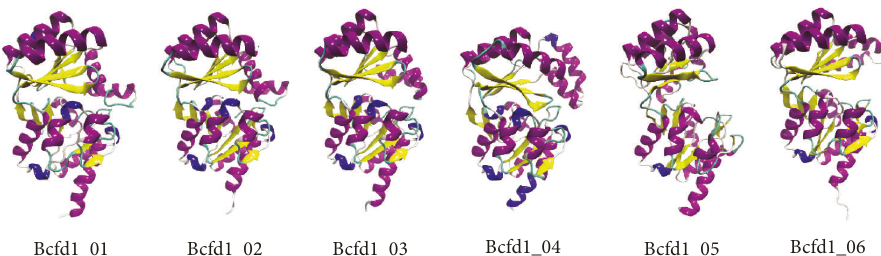
Figure 1: Predicted tertiary structure models of Bcfd1. Bcfd1_01, Bcfd1_02, Bcfd1_03, Bcfd1_04, Bcfd1_05, and Bcfd1_06 were obtained using I-Tasser, Robetta, TrRosetta, Robetta ab initio, C-Quark, and RaptorX, respectively. All models possessed similar main domain with slightly different on its cap domain.